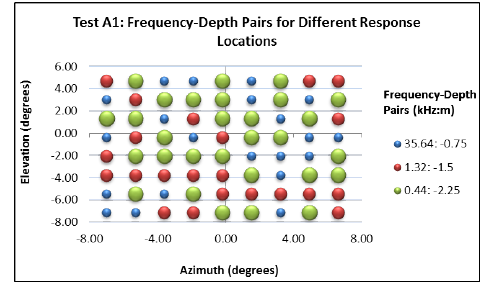
Figure 11: The Frequency-Depth pairs for different response lo- cations for first test of set A